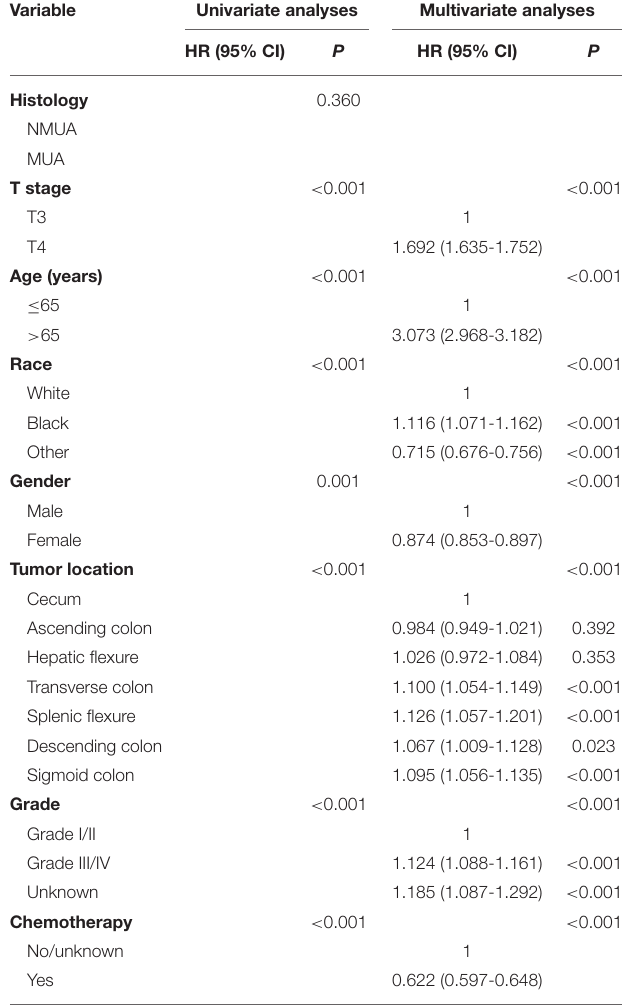
TABLE 2 | Univariate and multivariate analyses of prognostic factors in stage II colon